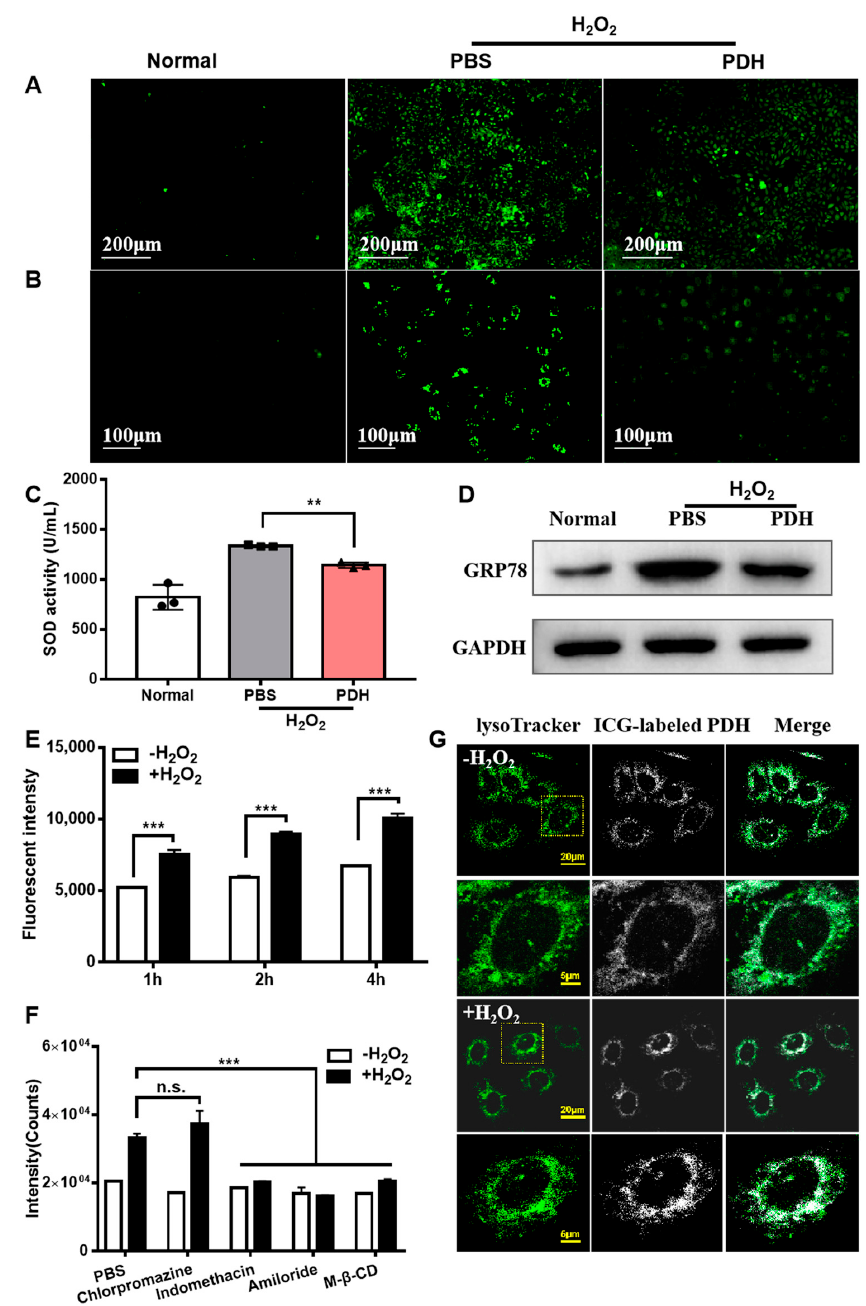
Figure 3. In vitro therapeutic mechanism of PDH nanoparticles (50 µ g/mL). ( A ) The ROS levels in cells after different treatments using the DCFH-DA probe. ( B ) The concentrations of free calcium ions in cells after different treatments detected with Fluo-4 AM probe. ( C ) The SOD activity in cells after different treatments was detected by total SOD assay kit with WST-8. Three circles in the figure mean three samples detected in the normal group. Three squares indicate three samples investigated in the PBS group. And three triangles represent three samples detected in the PDH group. ( D ) The expression levels of GRP78 in cells after different treatments were analyzed by Western blot. ( E ) The fluorescent intensities in cells treated with ICG-labeled PDH nanoparticles in the presence or absence of H 2 O 2 for 1 h, 2 h, and 4 h were measured by flow cytometry. ( F ) The fluorescent intensity at 4 h in cells pretreated with different internalization inhibitors was measured by flow cytometry. ( G ) The co-localization of the lysosome tracker and ICG-labeled PDH nanoparticles at 4 h. (n.s. is non-significant, ** p < 0.01, *** p < 0.001, n = 3).